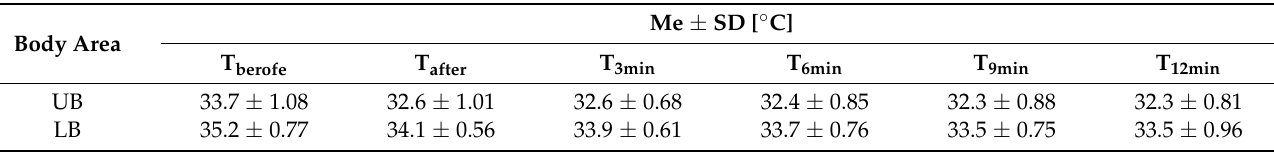
Abbreviations: UB–upper back; LB–lower back. Mean ± SD [ ◦ C] ANOVA